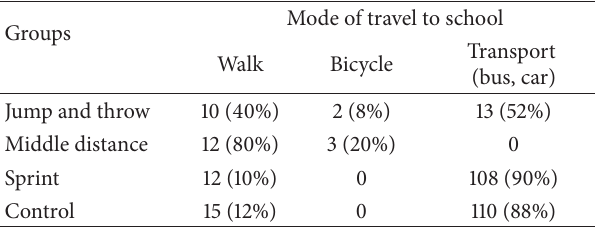
Table 1: Mode of travel by